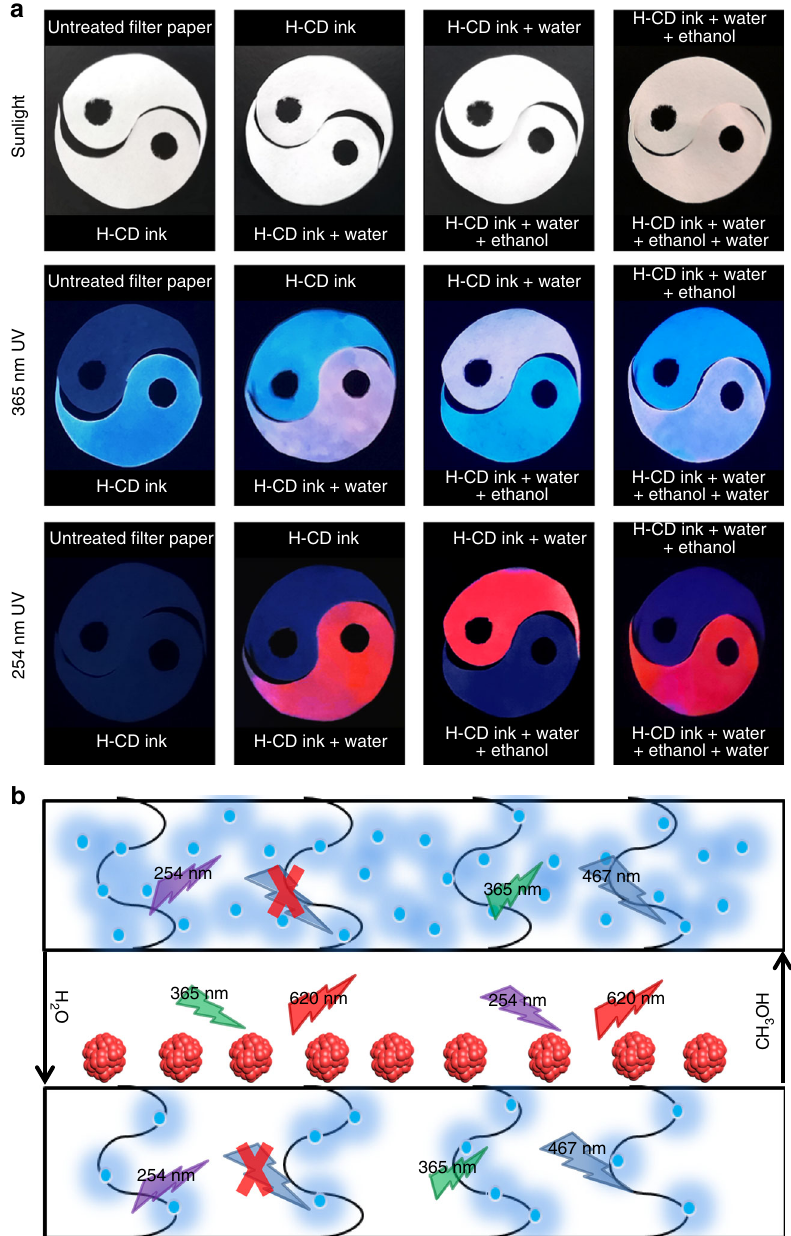
Fig. 6 Presentation and principle of H-CDs ’ reversible dual- fl uorescence. a Photographs of fi lter papers with different treatment under variable irradiation. b Schematic diagram of the H-CDs precipitated with water addition and redissolving into ethanol, with the resulting multimode fl uorescence. (The square frames represent the fi lter paper, the wavy lines represent the paper ’ s fi bers, the blue dots represent the H-CD monomers, the fl ash symbols upward refer to admit light while the downwards ones present emission, the red crosses mean no emission). H-CD, hydrophobic carbon